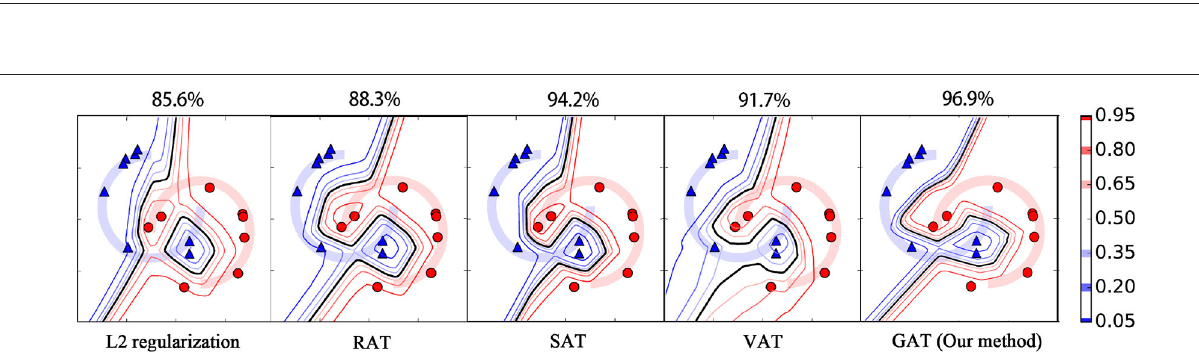
FIGURE 3 | The visualization of model distributions of GAT and Plain NN on the synthetic datasets. (A,B) Show the distribution surface on M -dataset, (C,D) show the distribution surface on C -dataset, where flat surface regions implicate small output deviations.